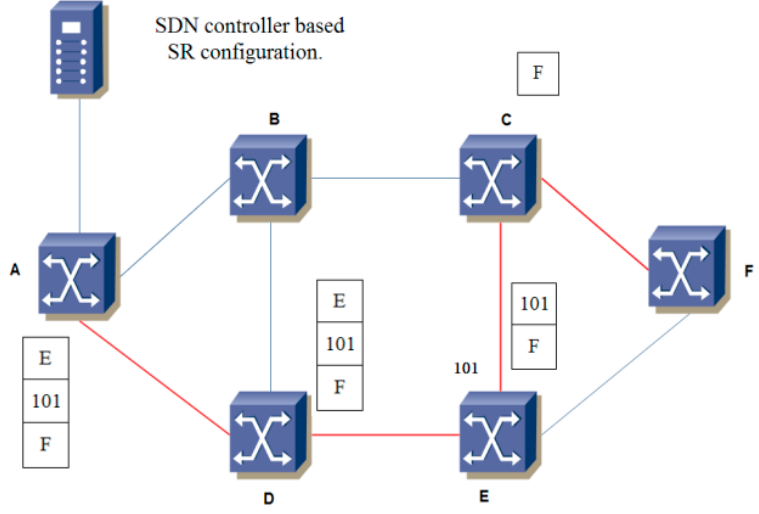
Figure 1. Segment routing based on SDN.